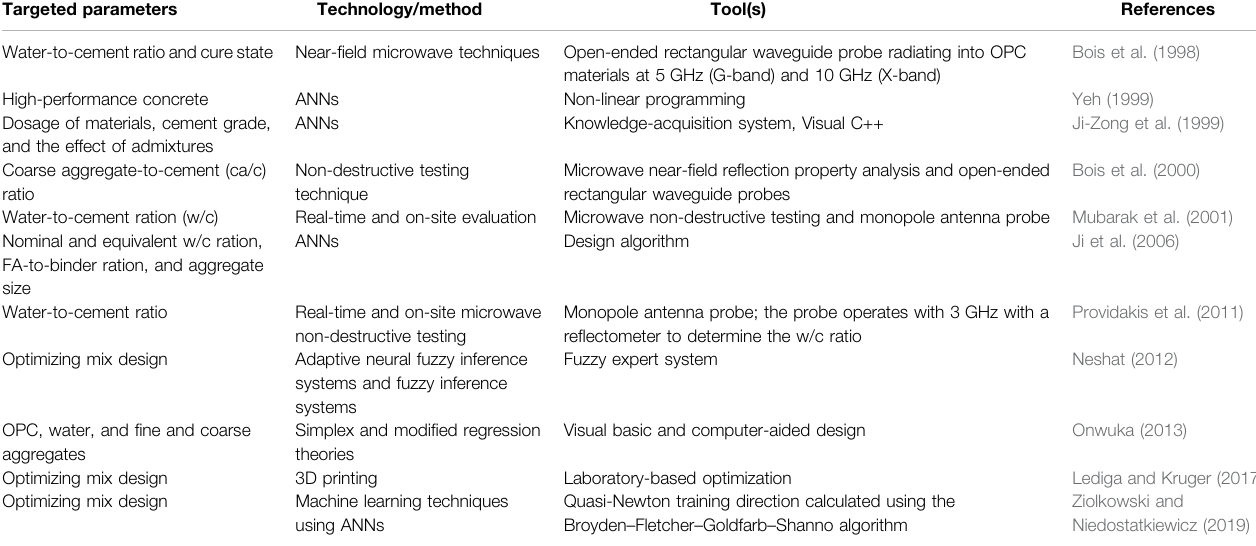
TABLE 3 | Digitalization of the mix